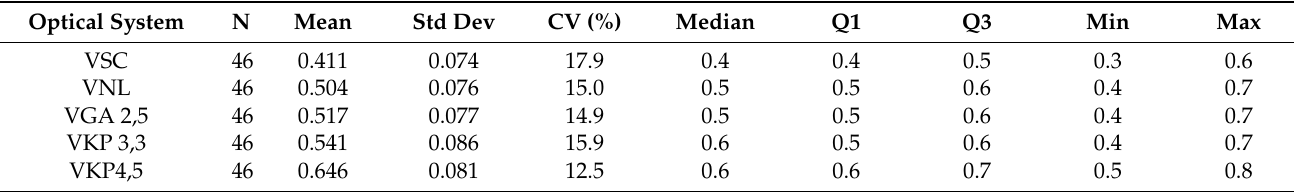
Table 1. Descriptive indicators of visual acuity distribution